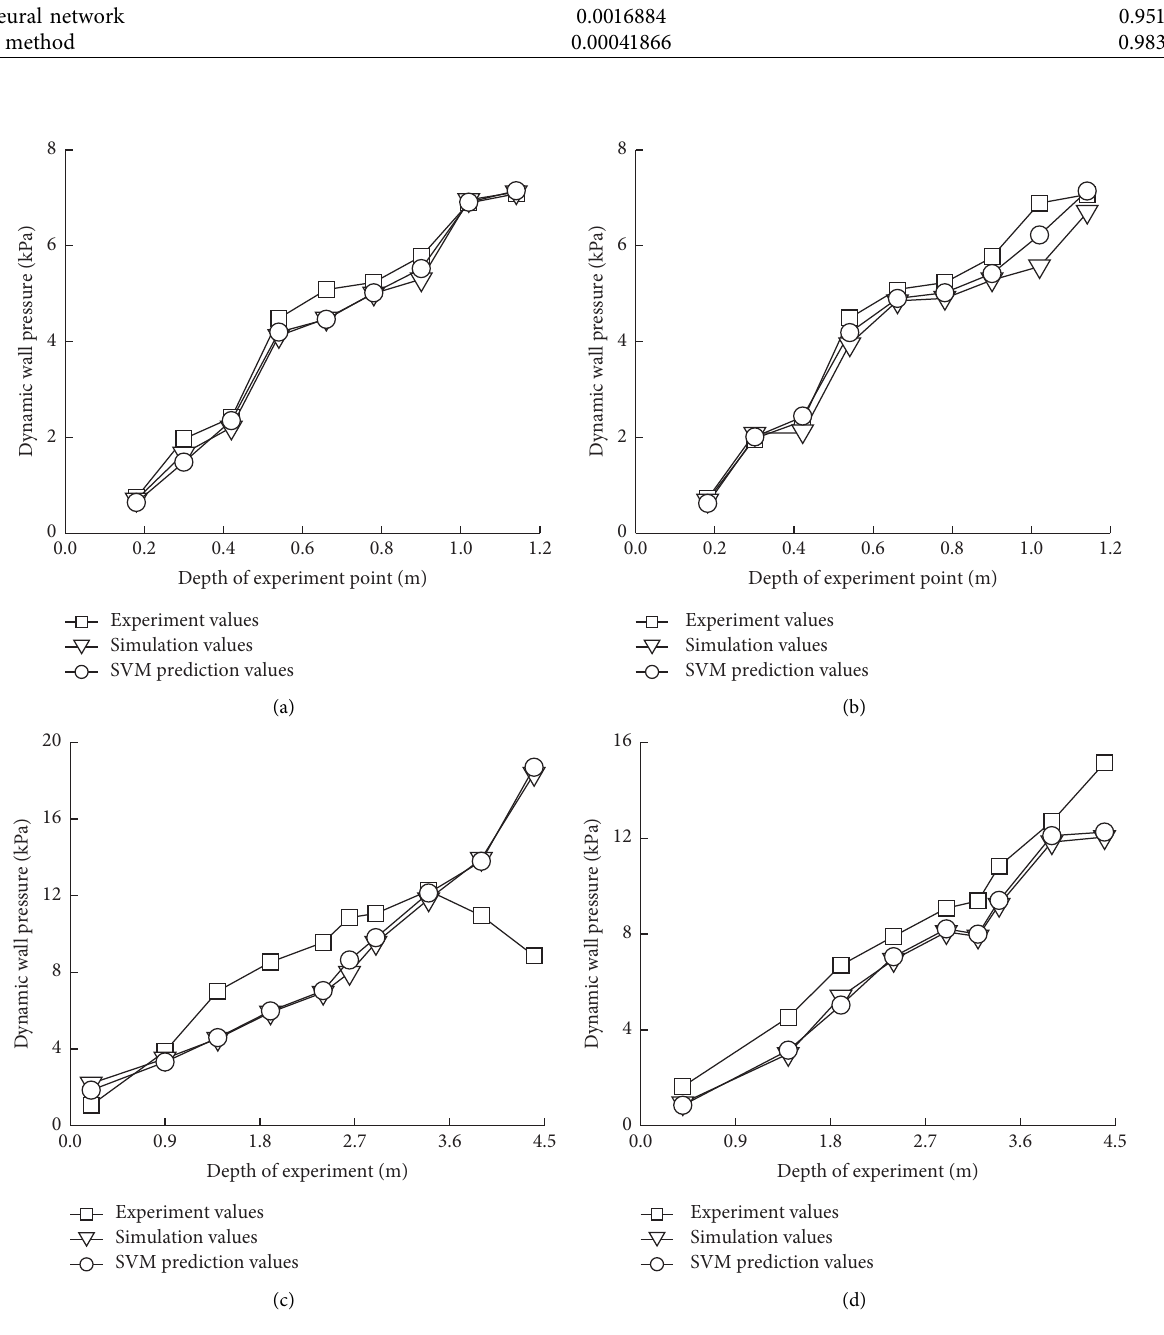
Figure 5: Comparisons with experiment values, simulation values, and prediction values. (a) For literature [18]. (b) For literature [19]. (c) For literature [20]. (d) For literature